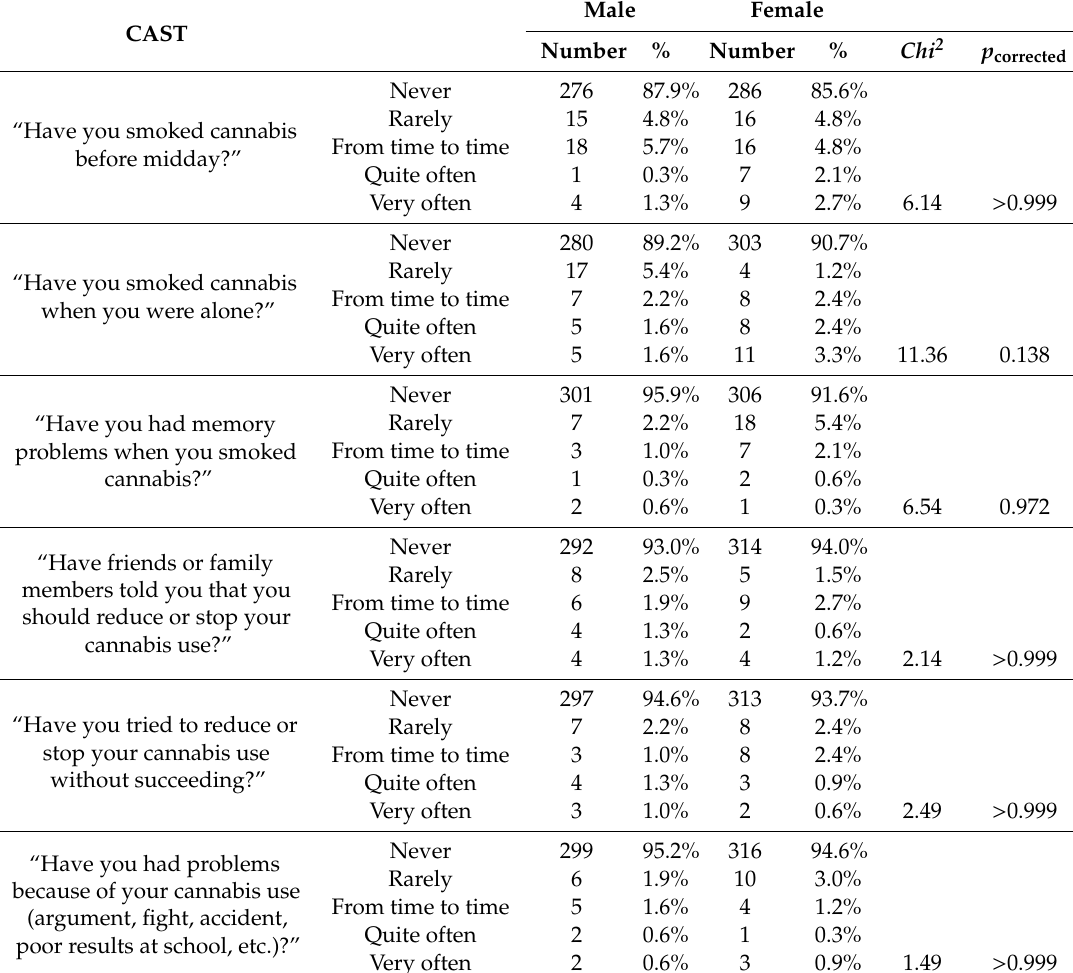
Table2. Frequencyofproblemsassociatedtocannabisuseaccordingtothecannabisabusescreeningtest. CAST